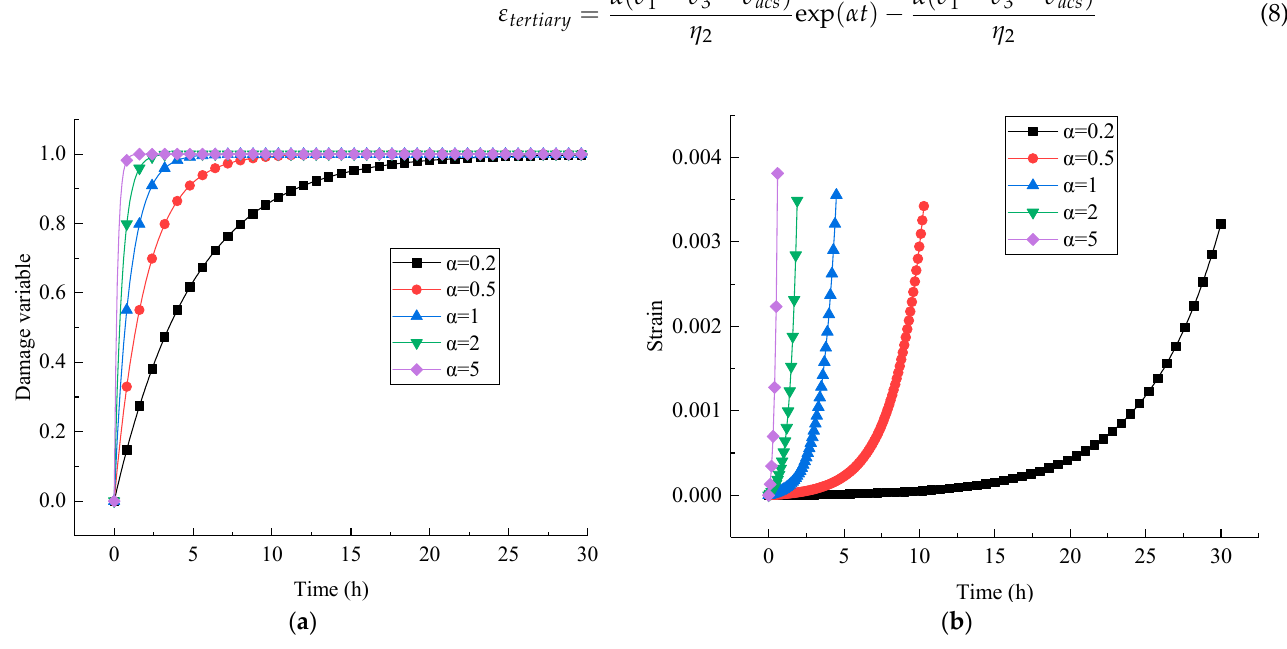
Figure 13. Effect of rock damage index α on the ( a ) damage variable and ( b ) strain curves under the last level of deviatoric stress with a confining pressure of 9 MPa.